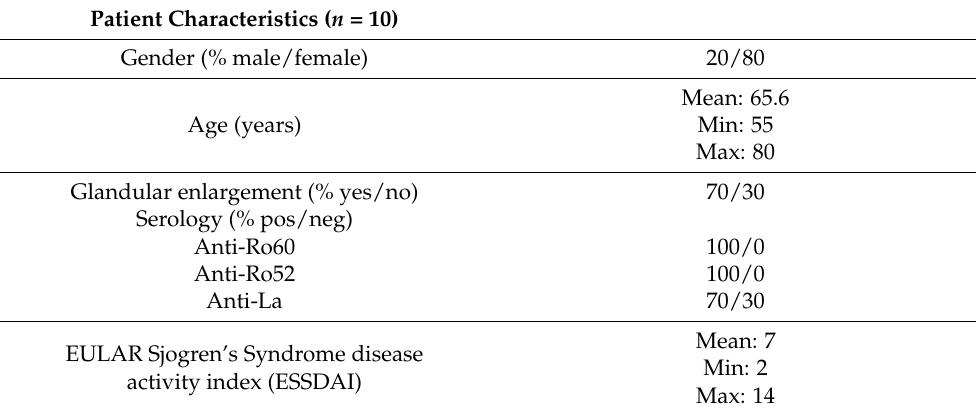
Table 1. Patient demographics. Patient Characteristics ( n =